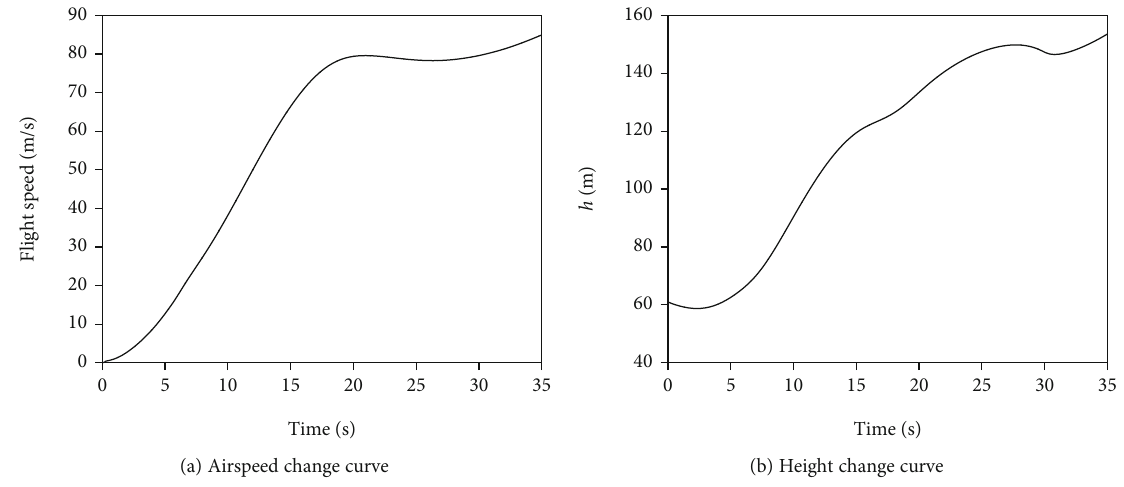
Figure 16: The airspeed and height change curves in conversion mode.